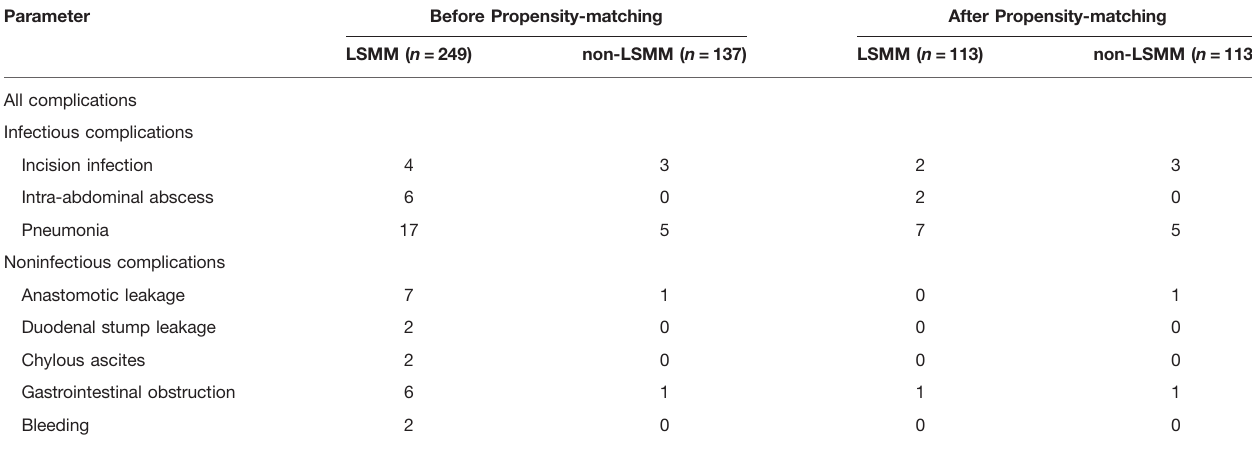
TABLE 3 | Postoperative complications between patients with LSMM or non-LSMM.